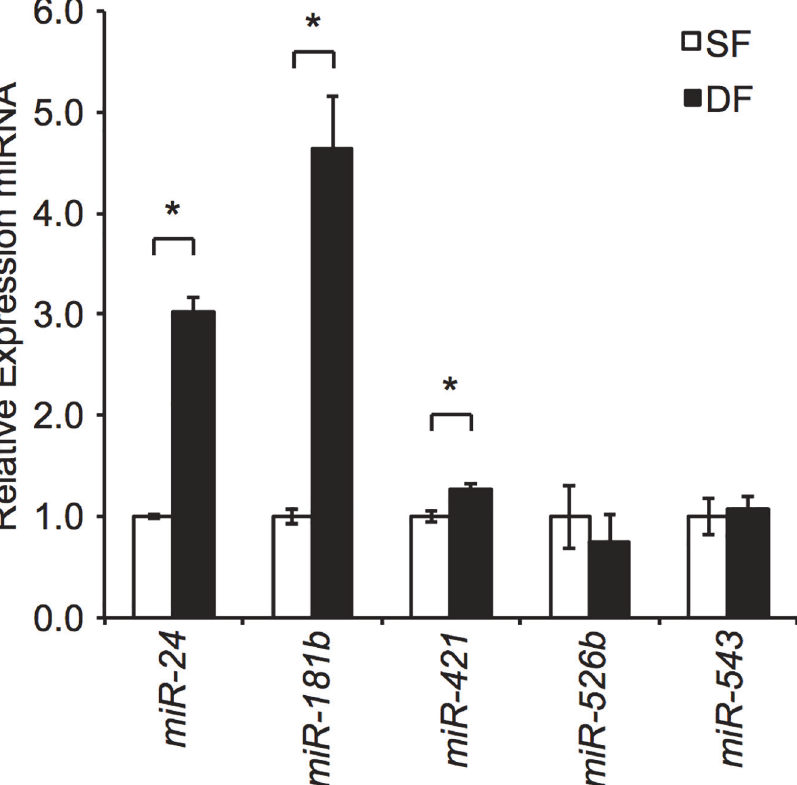
Fig 2. Evidence for the involvement of miRNA in DCN downregulation in DF. Total RNA was extracted from SF and DF cell culture after 48 hours and relative expression of selected miRNA quantitated using RT- qPCR (mean ± SEM, n = 3, * P <